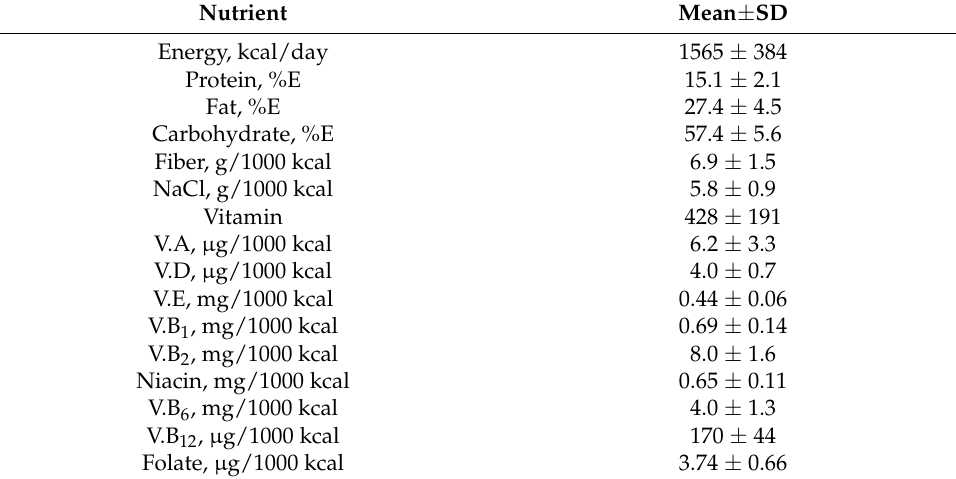
Table 6. Daily nutrient intakes reported on the